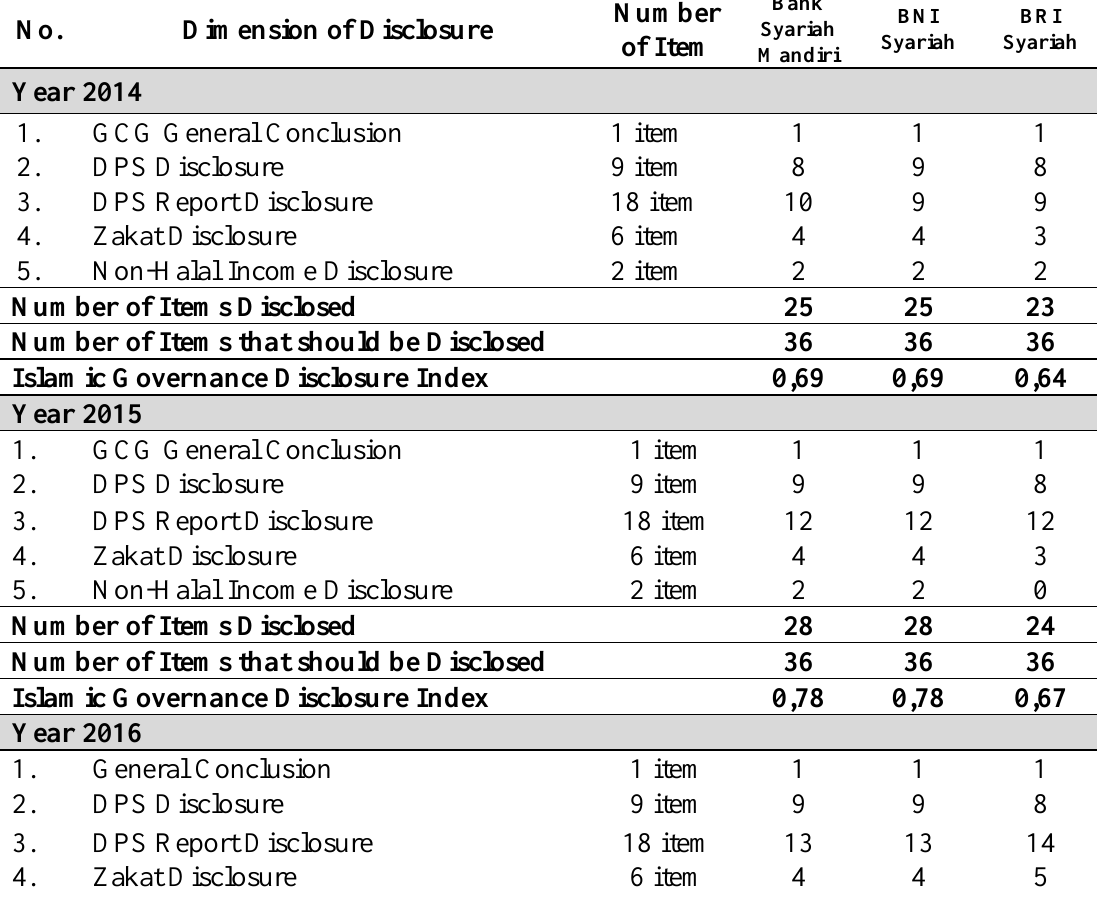
Table 8 Comparison of Islamic Governance Disclosure Practices of Indonesia